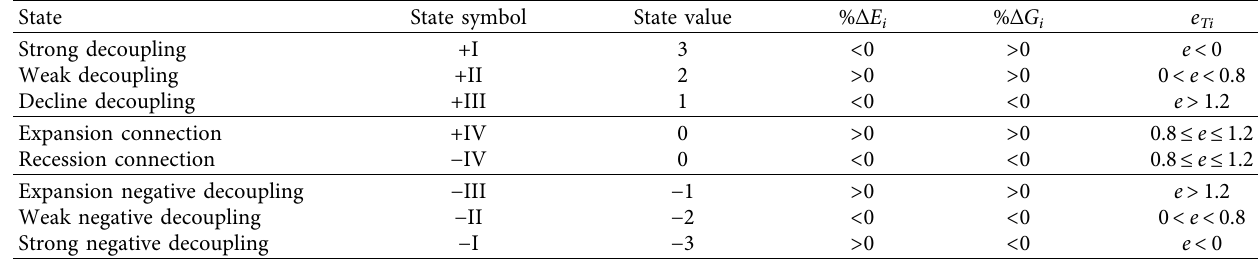
Table 4: Analysis model of decoupling state of energy